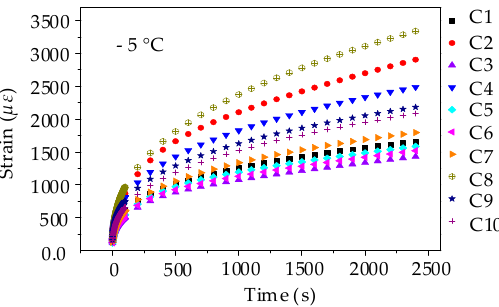
Figure 19. Creep strain ‐ time curves of asphalt mixture beams.